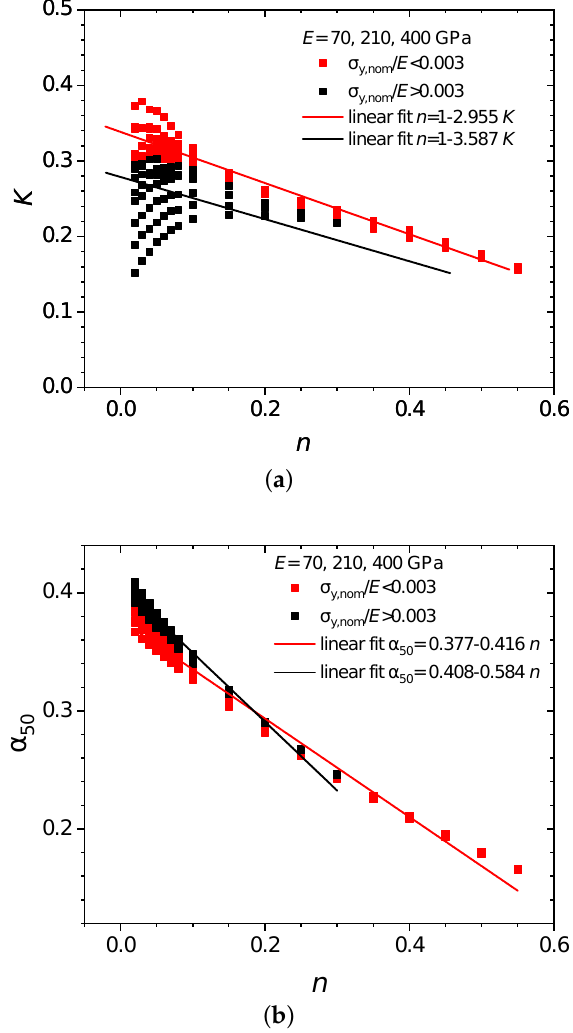
Figure 5. Linear regression fits for K vs. n ( a ) and α 50 vs. n ( b